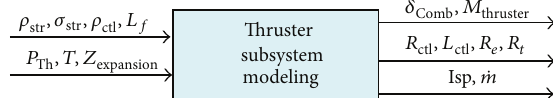
Figure 8: Input-output flow data of thruster subsystem